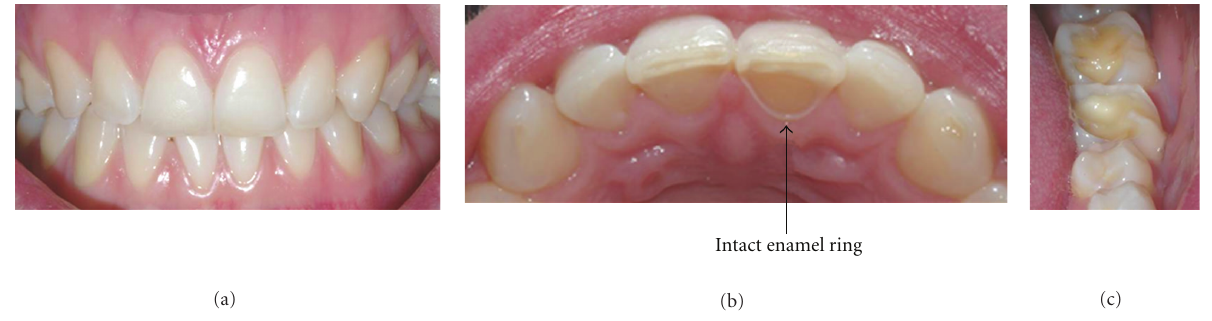
Figure 1: Varying severities of erosion observed in the (a) anterior maxillary facial surfaces, (b) anterior maxillary palatal surface, and (c) posterior mandibular occlusal surfaces of a 23-year-old